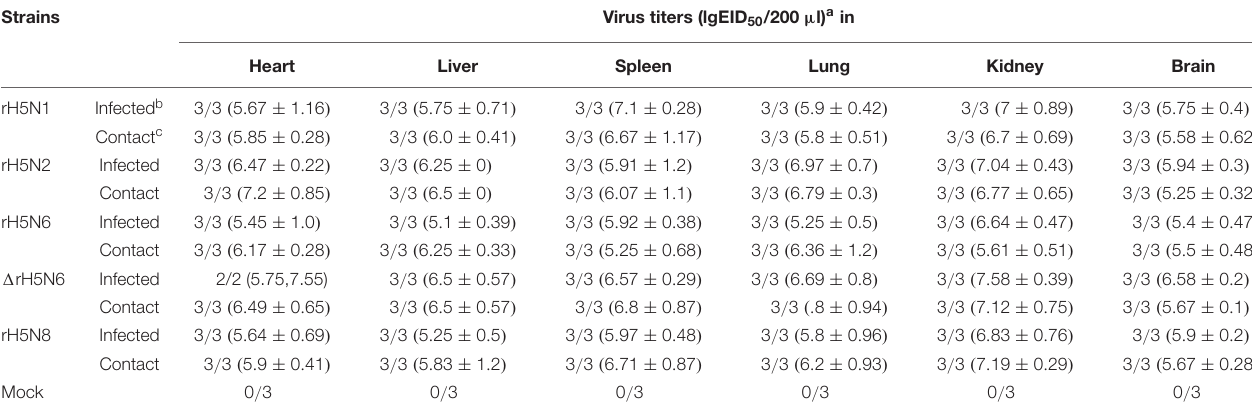
TABLE 1 | Viral distribution of the H5Nx reassortant viruses in chicken tissues (lgEID 50 /200 µ l). Strains